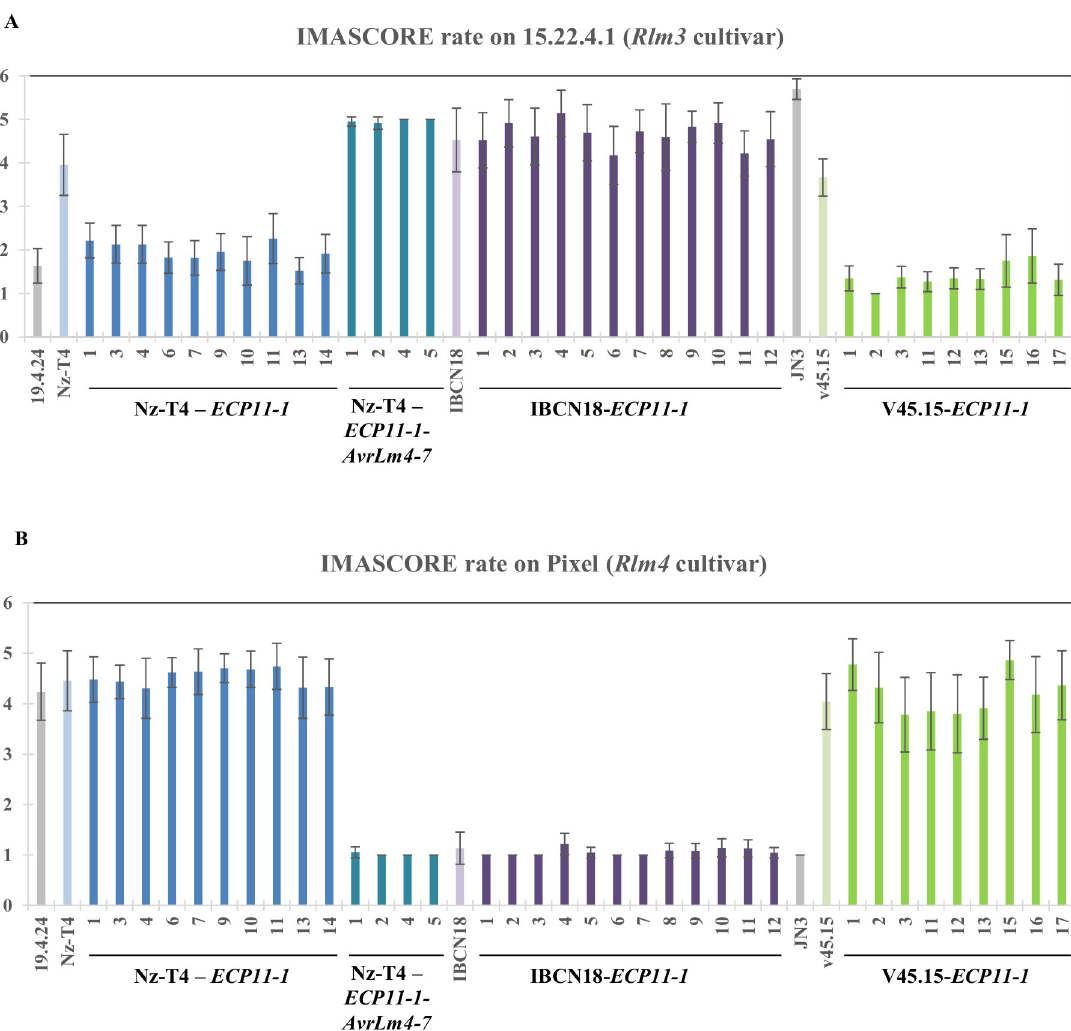
Fig 6. Ecp11-1 of F . fulva triggers Rlm3-mediated recognition in L . maculans , masked by AvrLm4-7. Wild type isolates Nz-T4 (a3a4a7), IBCN18 (a3A4A7) and v45.15 (a3a4a7), as well as Nz-T4, IBCN18 and v45.15 transformants carrying ECP11-1 , and Nz-T4 transformants carrying both ECP11-1 and AvrLm4-7 were inoculated onto cotyledons of a cultivar carrying Rlm3 (15.22.4.1, A) or Rlm4 (Pixel, B). Pathogenicity was measured 13 days post-inoculation. Results are expressed as a mean scoring using the IMASCORE rating comprising six infection classes (IC), where IC1 to IC3 correspond to resistance, and IC4 to IC6 to susceptibility [50]. Error bars indicate the standard deviation of technical replicates. 19.4.24 (A3a4a7) and JN3 (a3A4A7) were used as controls of the AvrLm3/Rlm3, and AvrLm4-7/Rlm4 and Rlm7 interaction phenotypes,